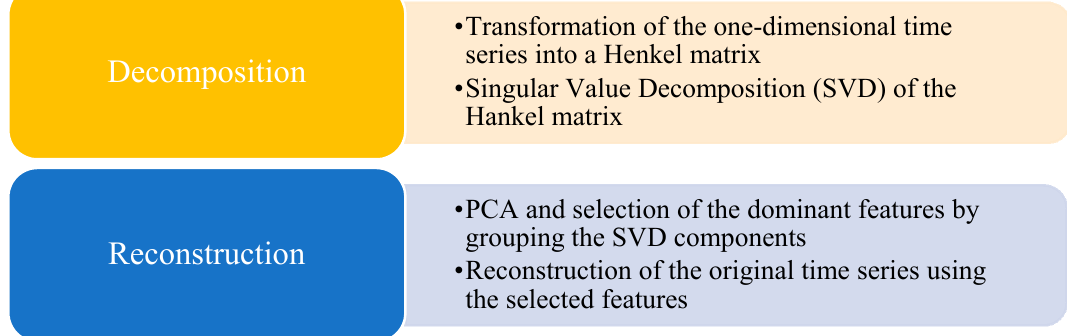
Figure 1. The standard Singular Spectrum Analysis (SSA) steps.